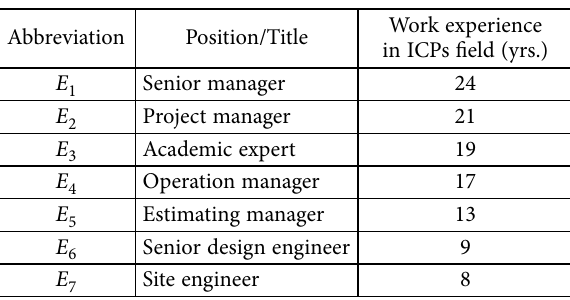
Table 1. A profile of selected experts in the